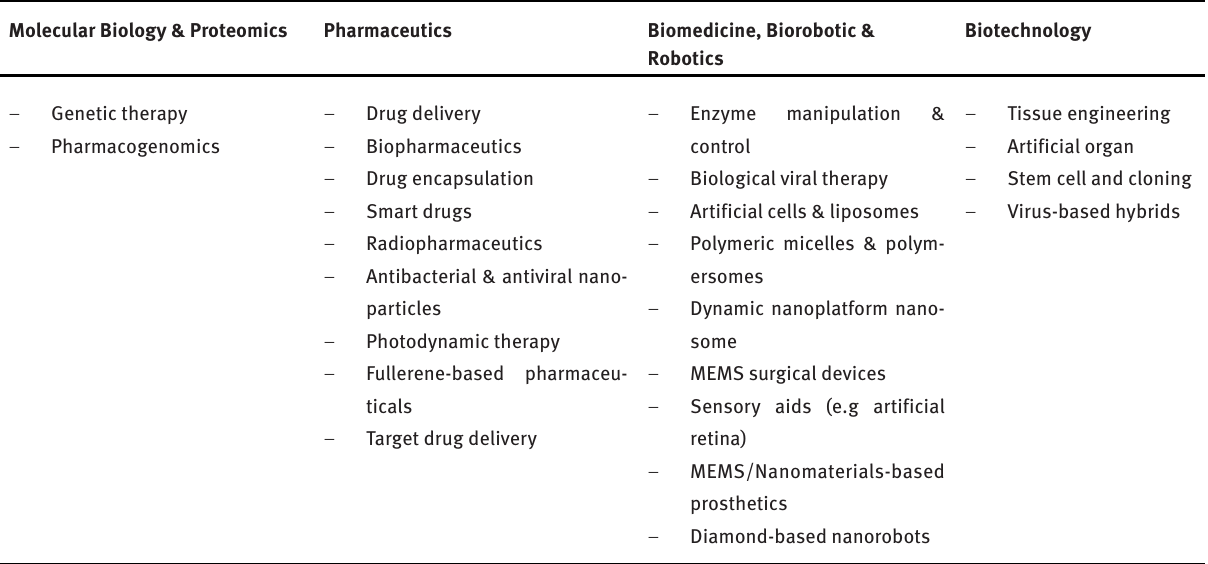
Table 3: Diverse fields in therapeutic